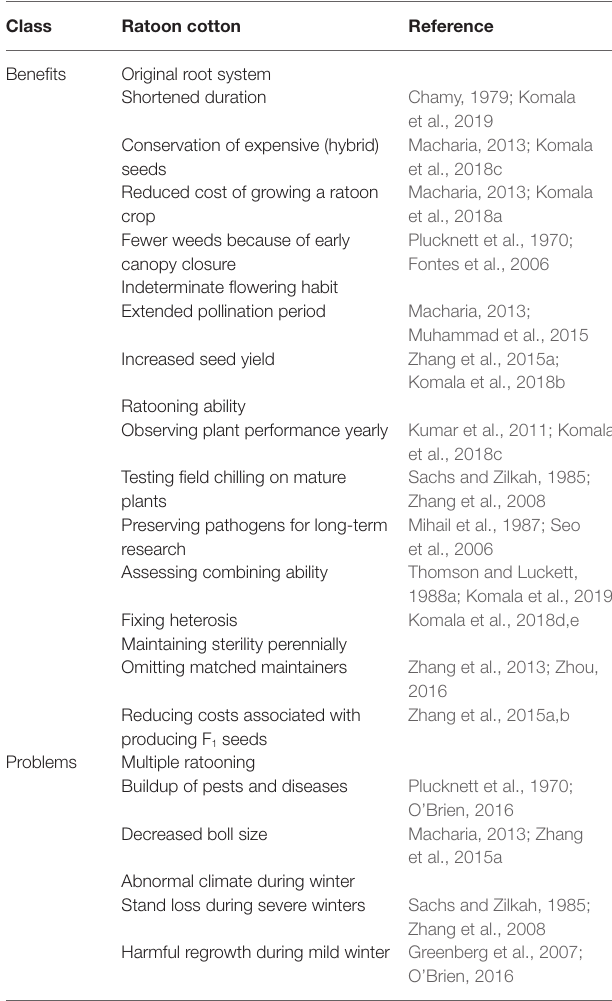
TABLE 1 | Benefits and problems of using ratoon cotton for heterosis utilization compared to sown